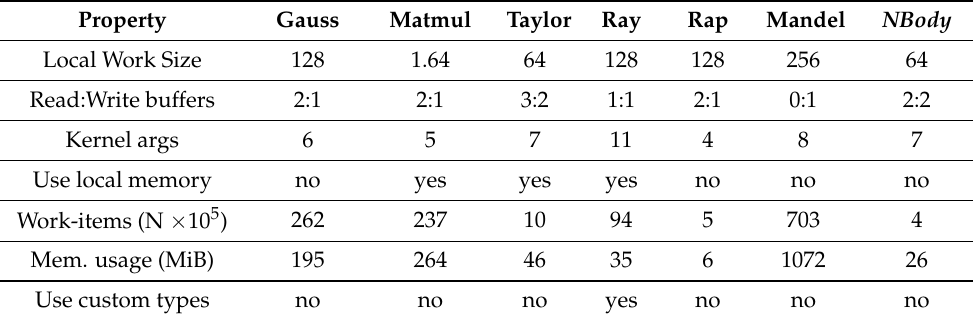
Table 1. Benchmarks and their